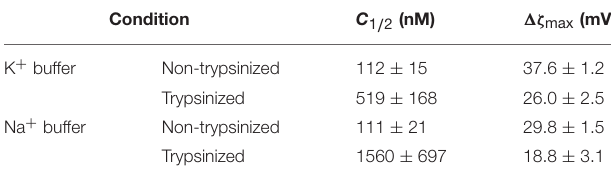
TABLE 1 | ζ -potential analysis of LDs titration with WNV C. Condition C 1 / 2 (nM) 1 ζ max (mV) K + buffer Non-trypsinized 112 ± 15 37.6 ± 1.2 Trypsinized 519 ± 168 26.0 ± 2.5 Na + buffer Non-trypsinized 111 ± 21 29.8 ± 1.5 Trypsinized 1560 ± 697 18.8 ± 3.1 The values shown (presented as mean ± SE) are the maximum amplitude of variation of the LDs ζ -potential ( 1 ζ max ) induced by the interaction with WNV C, and the WNV C concentration at 1 ζ max /2 (C 1/2 ). Values of C 1/2 and 1 ζ max were obtained through the fitting of ζ -potential experimental data using equation 3. K + and Na + buffers are TEE buffer with 100mM KCl or 100mM NaCl,